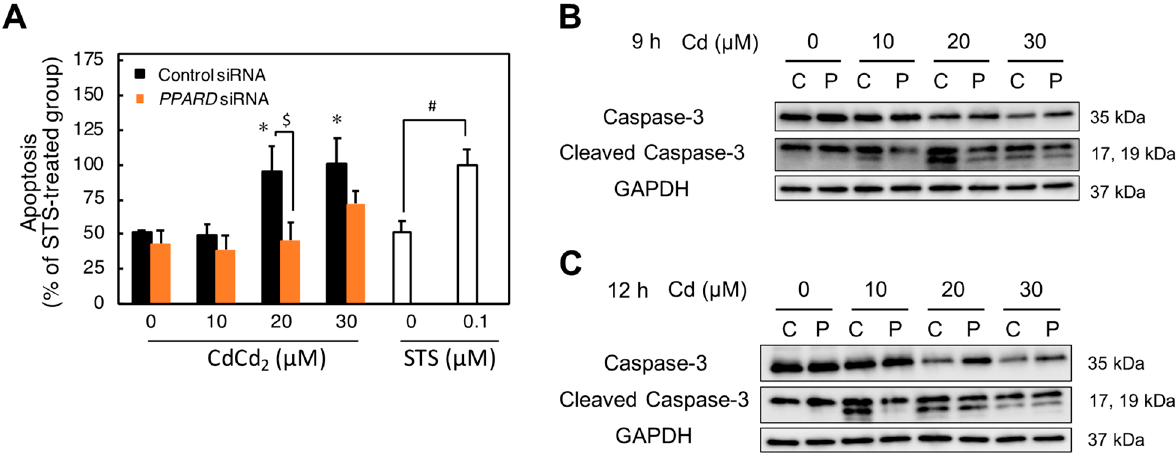
Figure 6. Effect of PPARD knockdown on apoptosis of HK-2 cells treated with Cd. ( A ) After treat- ment with PPARD siRNA for 48 h, HK-2 cells were treated with Cd for 12 h. HK-2 cells were treated with STS, as an apoptosis inducer, for 12 h. Apoptosis was examined by a Cell Death Detection ELIZA PLUS Kit after Cd and STS treatment for 12 h. Values are means ± SD ( n = 3). * Significantly different from the control siRNA + Cd 0 µM group, p < 0.05. $ Significantly different from the control siRNA group, p < 0.05. # Significantly different from the STS 0 µM group, p < 0.05. ( B , C ) After treat- ment with PPARD siRNA for 48 h, HK-2 cells were treated with Cd for 9 h ( B ) or 12 h ( C ). Protein levels of caspase-3 and cleaved caspase-3 were examined by western blotting after Cd treatment for 9 or 12 h. GAPDH was used as the loading control.